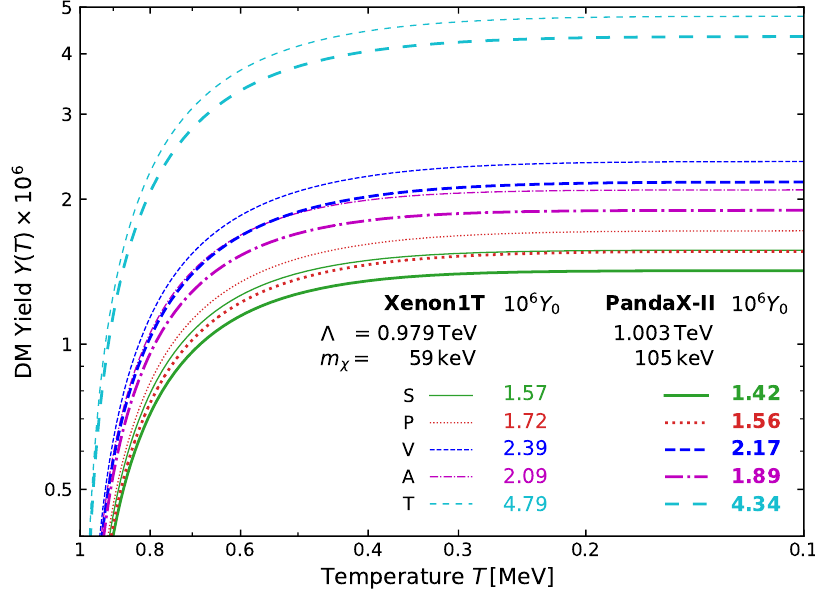
Figure 3 . The evolution of the DM yield Y ( T ) as function of temperature T for the DM absorption operators with the best-fit values m = 59 (105) keV and Λ = 0 . 979 (1 . 003) TeV of the Xenon1T χ (PandaX-II) data as shown in thin (thick) lines. The different fermionic DM absorption operators are shown with different line types and colors: scalar (S: green solid), pseudo-scalar (P: red dotted), vector (V: blue dashed), axial vector (A: purple dash-dotted), and tensor (T: cyan long dashed). Note that the colored light-face (bold-face) number is the rescaled DM yield today, 10 6 Y , for the 0 corresponding operator with the best-fit values of the Xenon1T (PandaX-II)